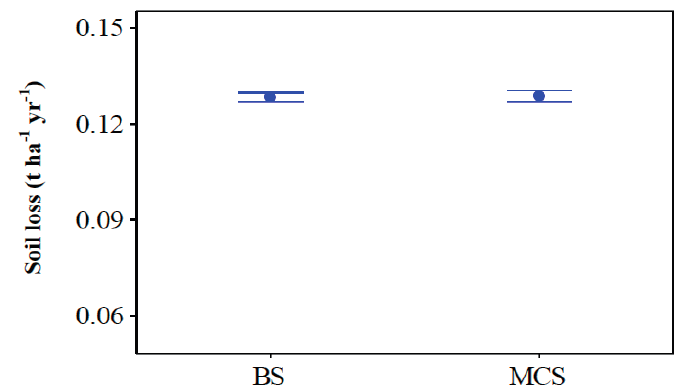
Figure 8. Simulated annual soil loss ( p < 0.05; confidence interval 95%).